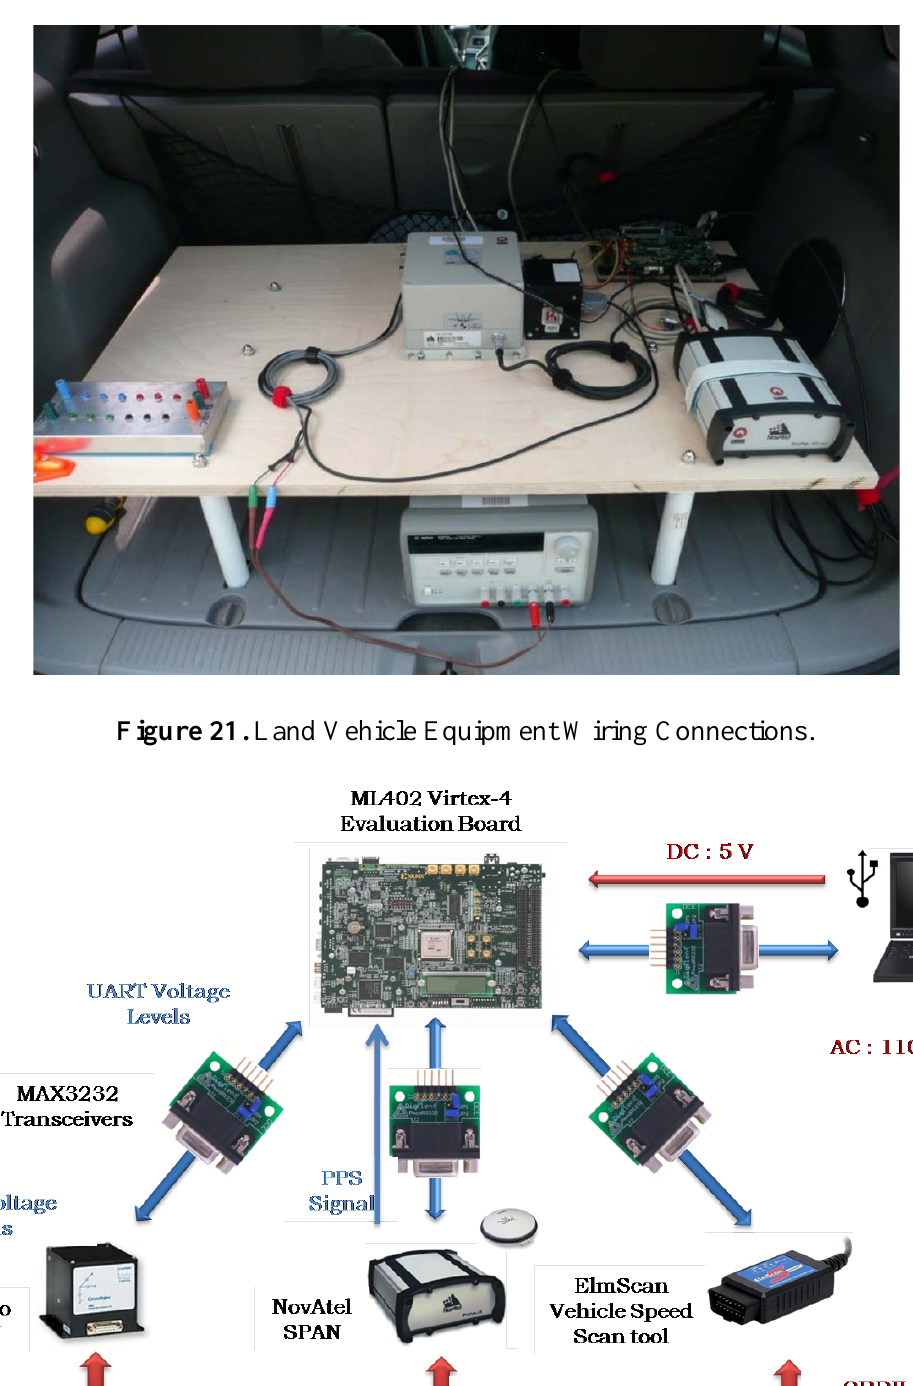
Figure 20. The Land Vehicle Experimental Setup.